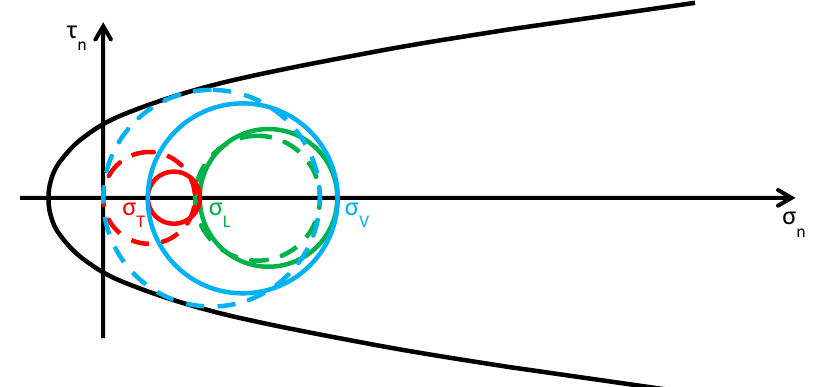
Figure 25. Stress analysis for 0 < σ T ≤ σ L (Mohr’s circles before retrofitting in dashed lines, for comparison).